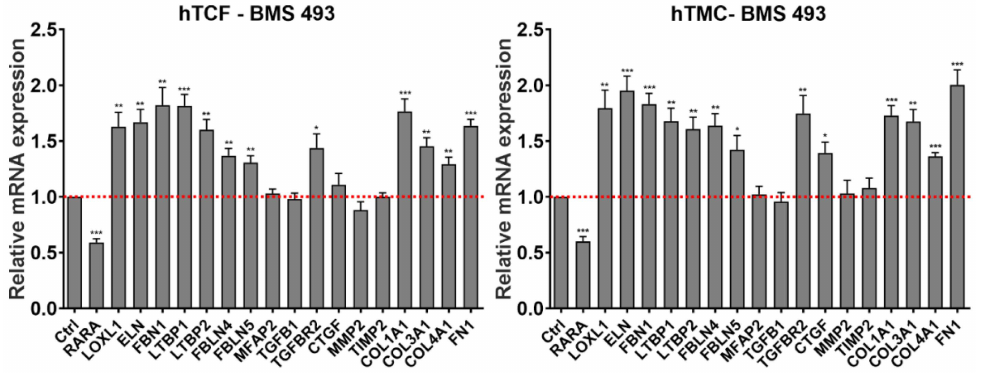
Figure 6. Effects of the RAR antagonist BMS 493 on matrix synthesis in PEX-relevant cell types. Quantitative real-time PCR analysis of RARA (retinoic acid receptor alpha), LOXL1 (lysyl